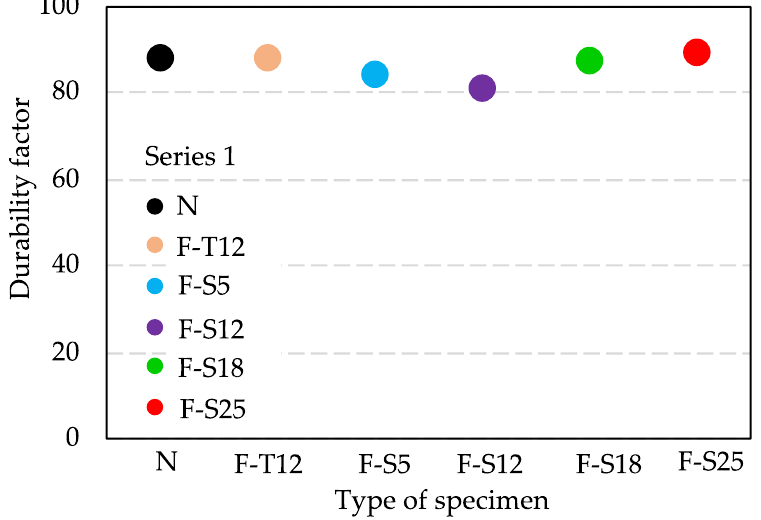
Figure 8. Durability factor results of Series 1.